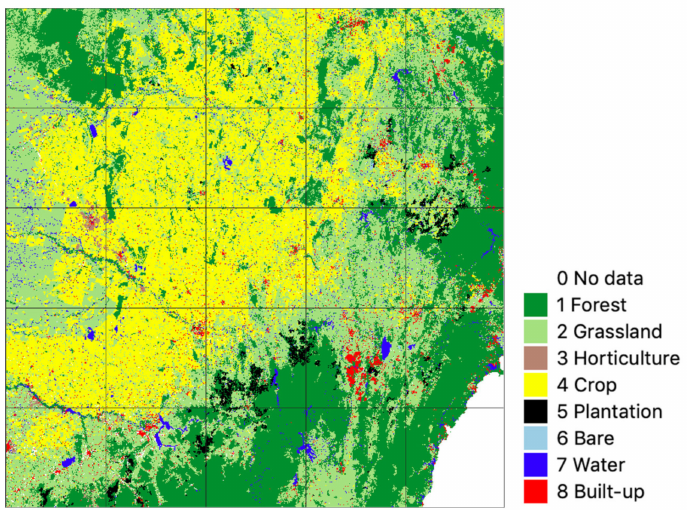
Figure 2. Label data (circa 2018)—simplified land cover map for study area (~500 km × 500 km) derived from CLUM [40]. Projection: GDA94/Australian Albers (EPSG: